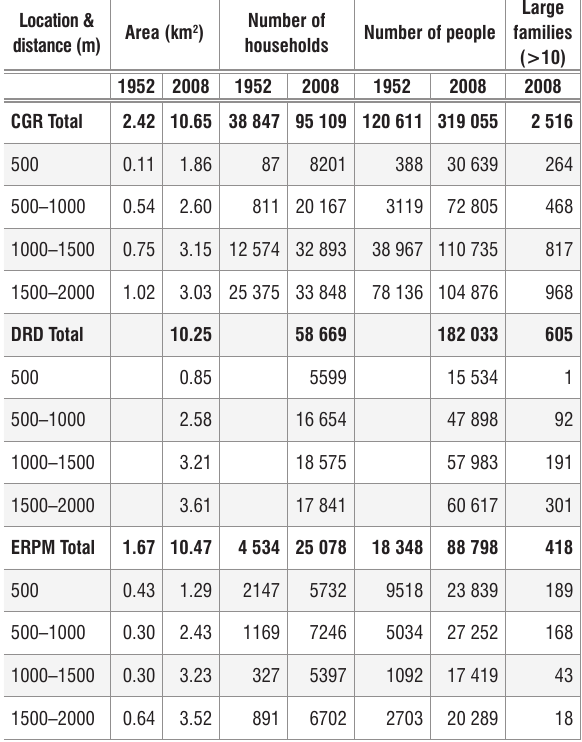
Population estimates for residential development around Crown Gold Recoveries (CGR), Durban Roodepoort Deep (DRD) and East Rand Proprietary Mine (ERPM) tailings storage facilities (TSFs) showing changes in the area and number of households or dwellings between 1952 and 2008 Location & Number of Area (km 2 ) distance (m)